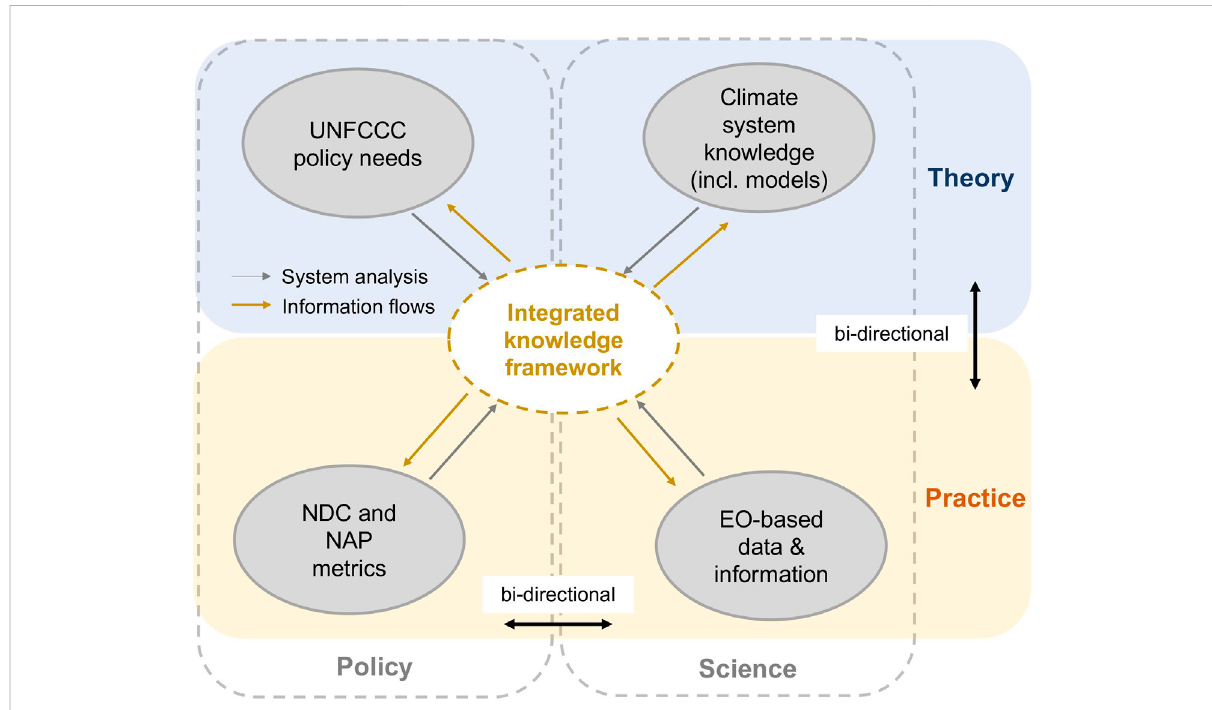
FIGURE 1 Multi-directional and trans-disciplinary methodological approach used in this study to derive an integrated knowledge framework that considers needs and opportunities from policy, science, theory, and practice on an equal footing. NDC and NAP are Nationally Determined Contributions and National Adaptation Plans. EO here refers to all available Earth observations, though the speci fi c focus of this paper is on space- based